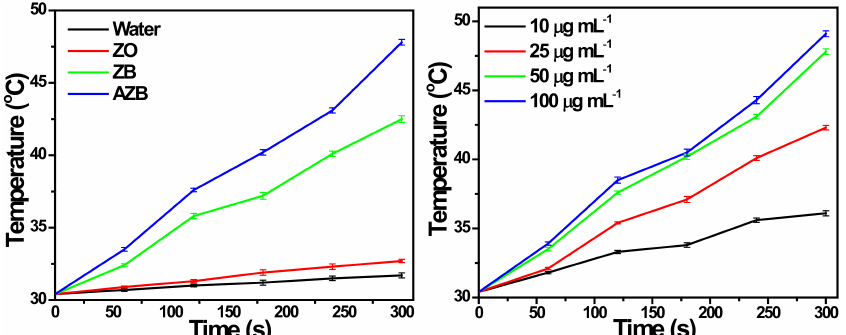
Figure 4. Photothermal temperature measurement. ( a ) Photothermal temperature increase observed for pure water and ZO, ZB, and AZB samples under NIR light irradiation. ( b ) Photothermal tempera- ture increment observed for the AZB samples with different concentrations (the data are shown as the mean of